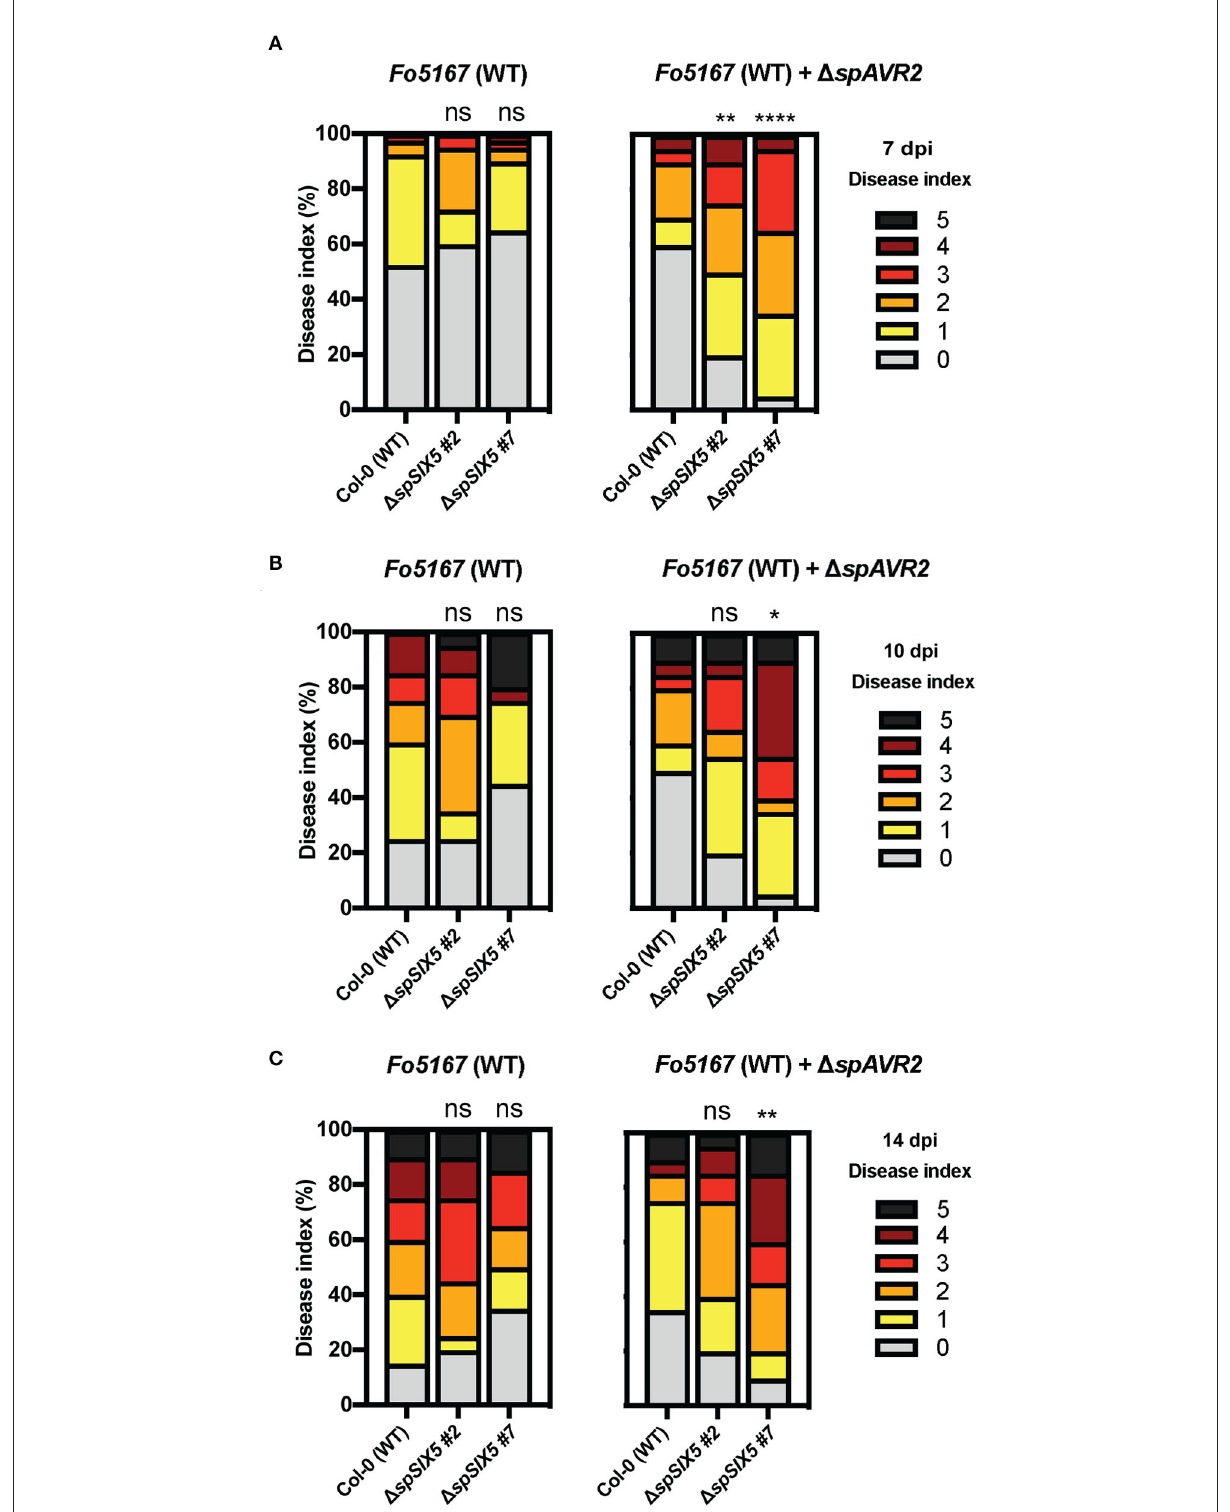
FIGURE1 SIX5- expressing Arabidopsis plants show increased disease symptom development during the early stages of infection with an AVR2- expressing Fo 5167 strain. Fourteen-day-old Arabidopsis plants (Col-0, 1 spSIX5 #2 , and #7 ) inoculated with wild-type Fo 5167 and AVR2- expressing transgenic Fo 5167. Disease index scored on an ordinal scale of 0 (no symptoms) to 5 (plant death) at (A) 7 days post-inoculation (dpi), (B) 10 dpi,